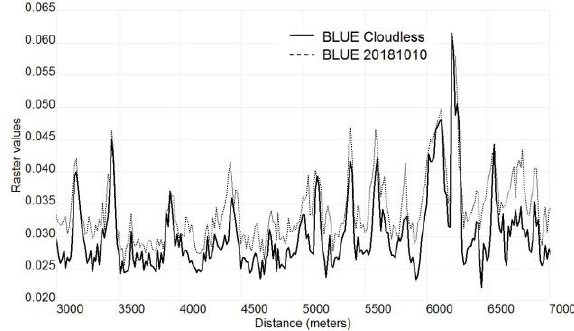
Figure 18. Spectral profile of the Blue band reflectance along a transect for both reconstructed image and reference